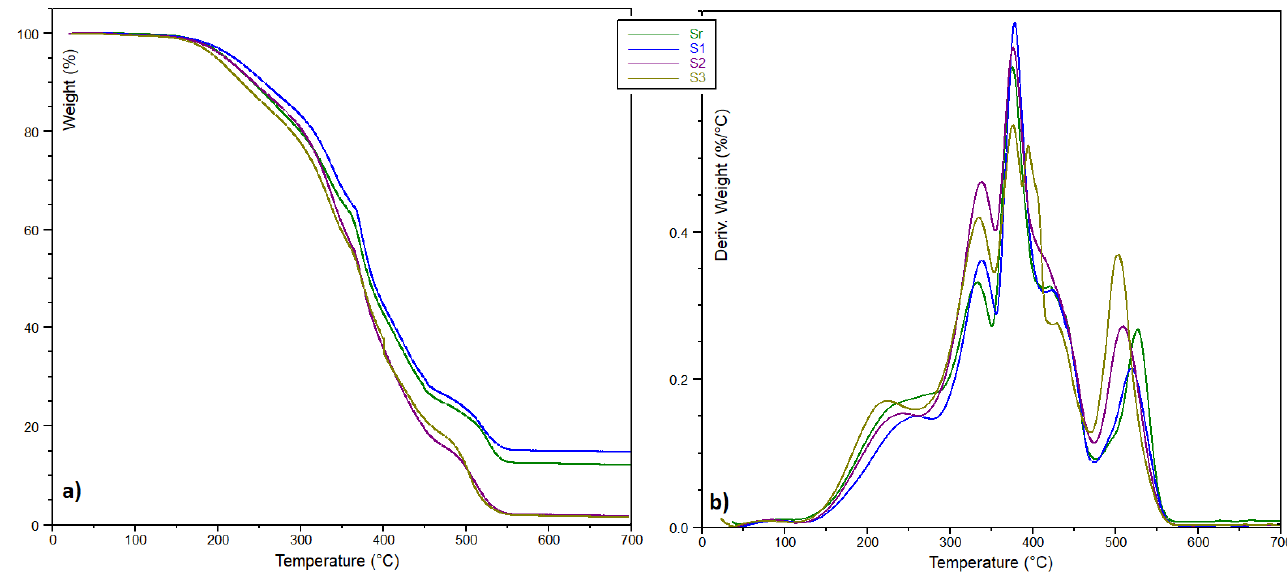
Figure 4. Thermal degradation profile (air) of ELO-LnK composites. ( a ) TGA and ( b ) DTG curves. The degradation behavior (Figure 4b) could be related to the LnK amount, but also An influence of LnK upon thermo-oxidation processes is also clearly observed, this stage involving probably degradation of LnK substituents. In case of S3 (15% wt. LnK molecular weight segments within the cross-linked content), two peaks can be observed at 376 and 395 °C, respectively, and a small shoulder